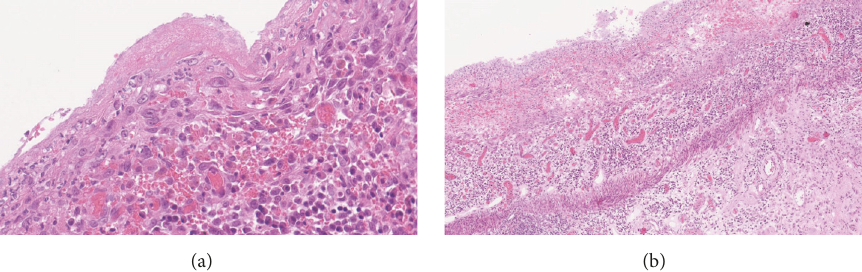
Figure 1: Histological sections of the transplanted bowel taken in April 2016 prior to complete explantation. (a) shows ulceration with a fibrinous exudate and granulation tissue formation consistent with severe colitis. (b) shows ulceration to the level of the muscularis propria as well as abundant ulcer slough consistent with our assertion that the regenerative state of the bowel could not be assessed adequately by histology.